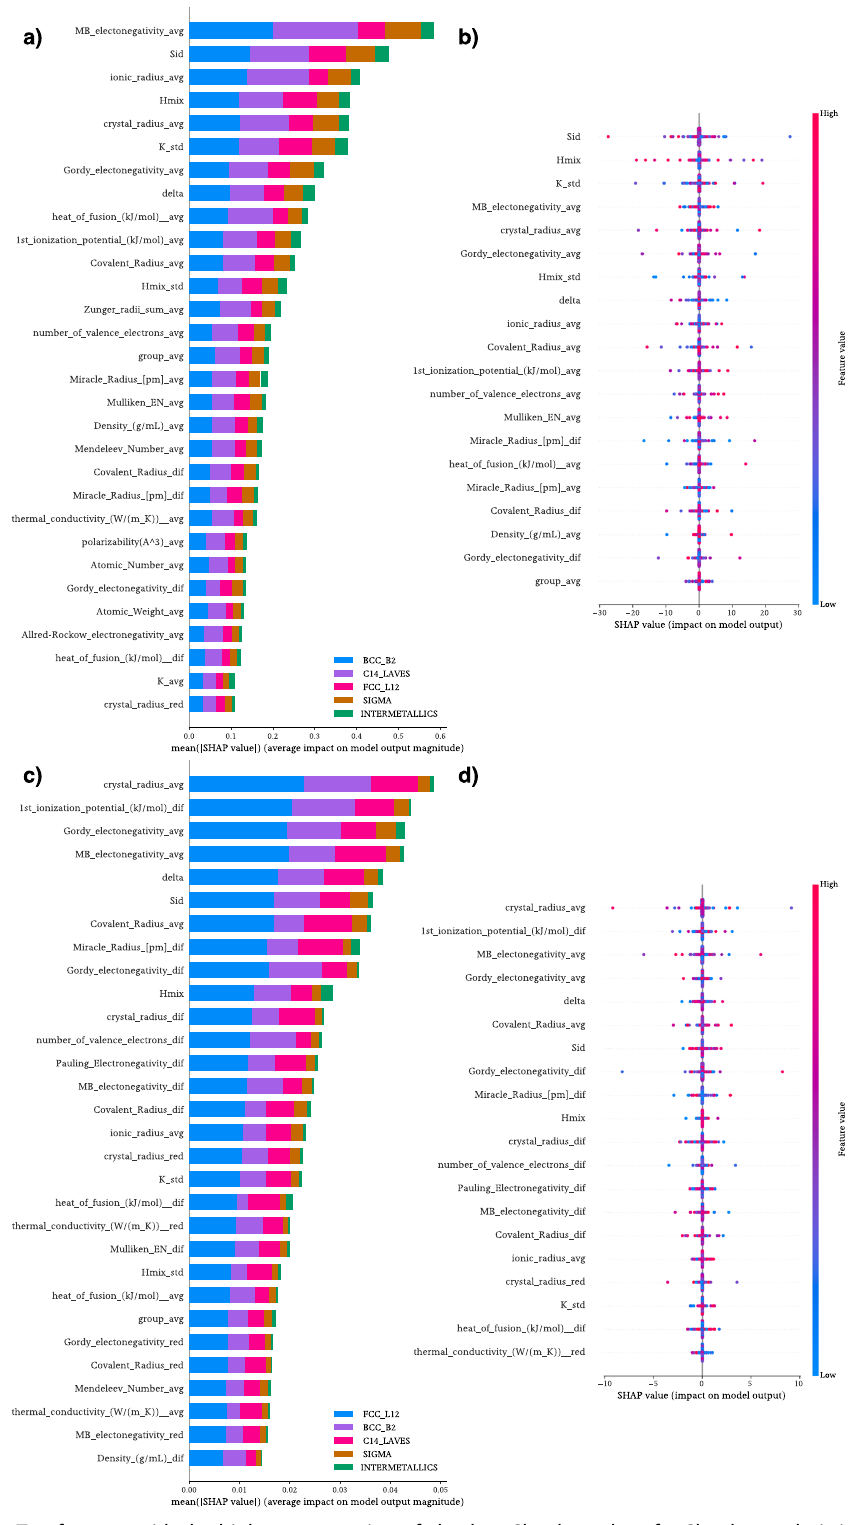
Fig. 5 Shapley analysis. Top features with the highest summation of absolute Shapley values for Shapley analysis in a ( a ) random subset of 5000 samples for all model classes and c 5000 high FCC phase fraction alloys. b and d correspond to the same background data, respectively, but only looking at the single FCC